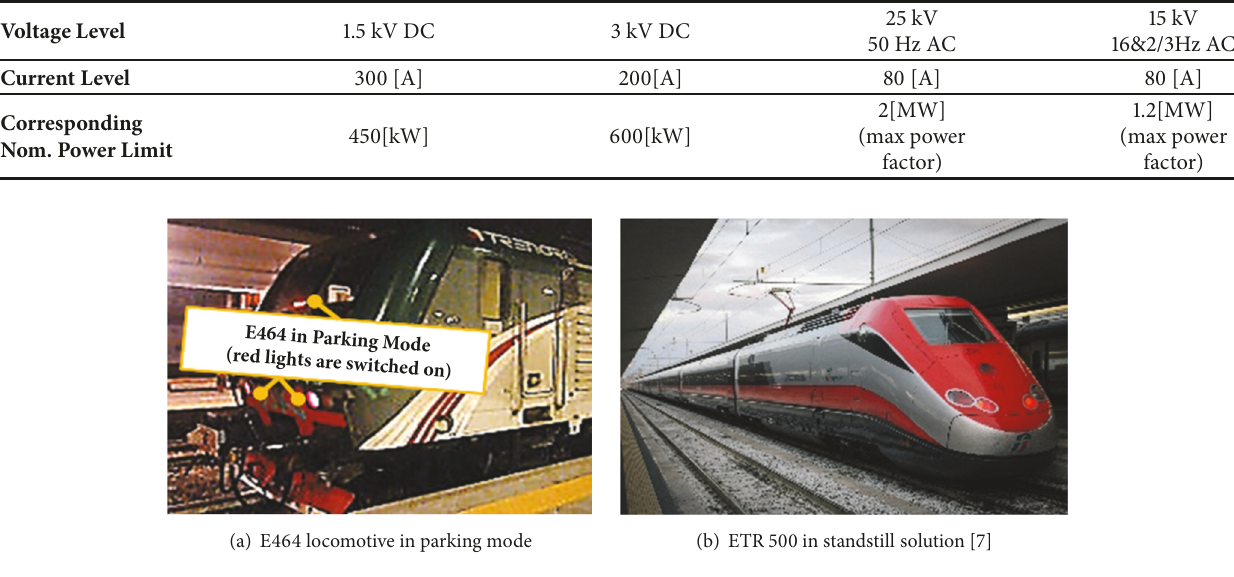
Figure 1: Examples of trains in parking